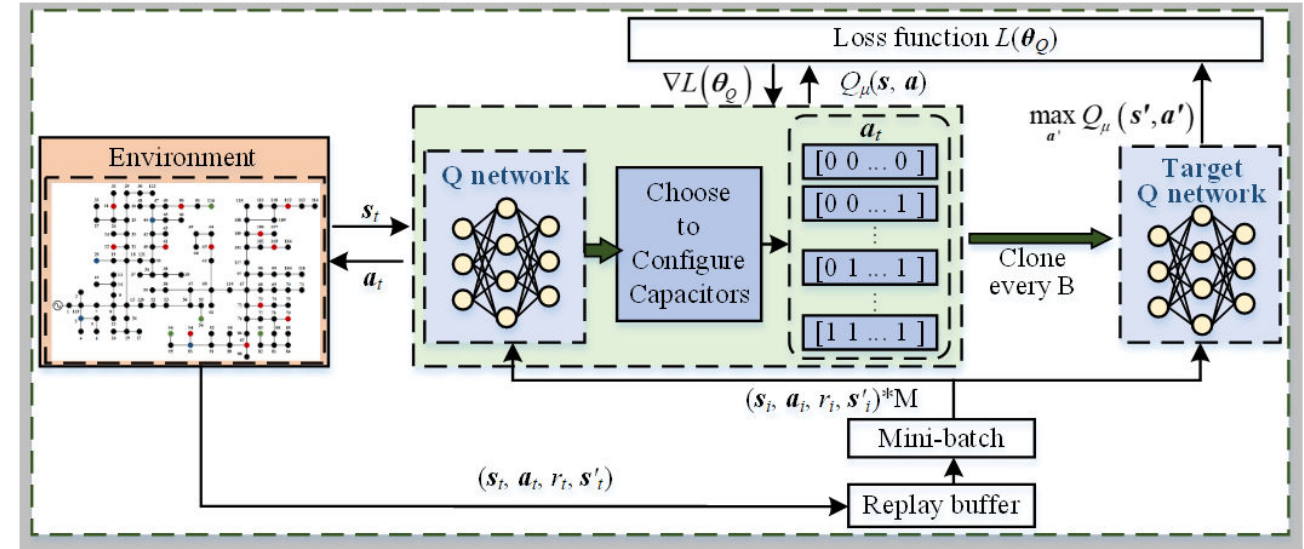
Figure 1. The control of capacitors based on the DQN